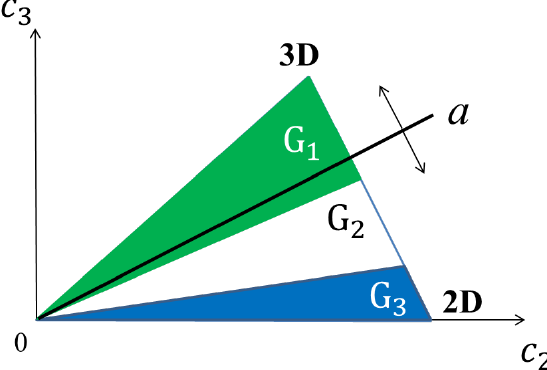
Figure 3. Scatterplot of c 2 and c 3 . 𝜆 𝑖 stands for eigenvalues of each component and c i are their proportion described by Equation (1). According to point distribution, 1D denotes the data that have a linear arrangement, 2D denotes the data that are on a plane and 3D denotes the data that are randomly scattered.